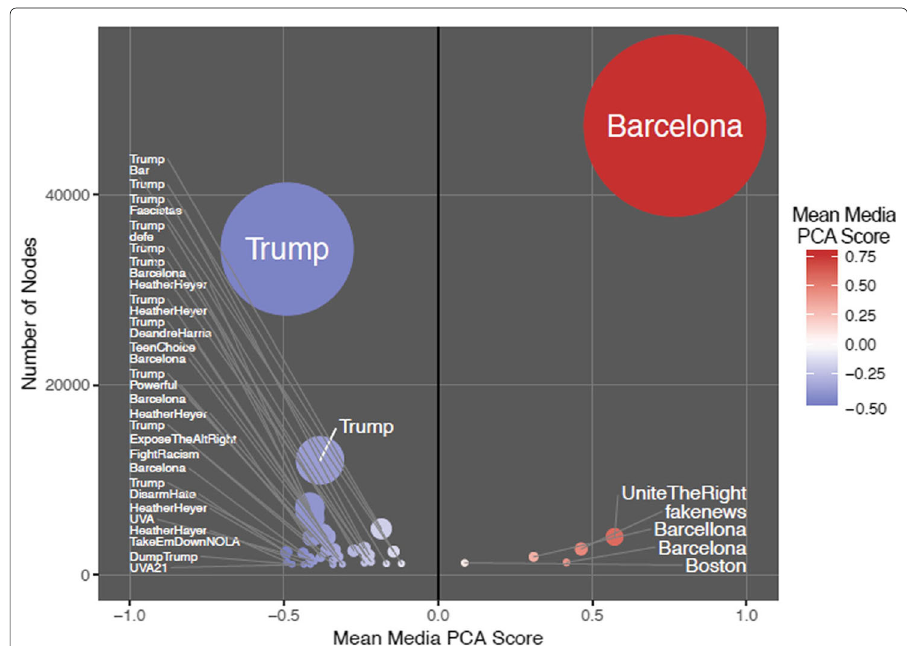
Fig. 6 Most common hashtags for communities from modularity maximization with at least 1,001 nodes. The mean media PCA score is on the horizontal axis (and is also indicated by the color bar), and the number of nodes is on the vertical